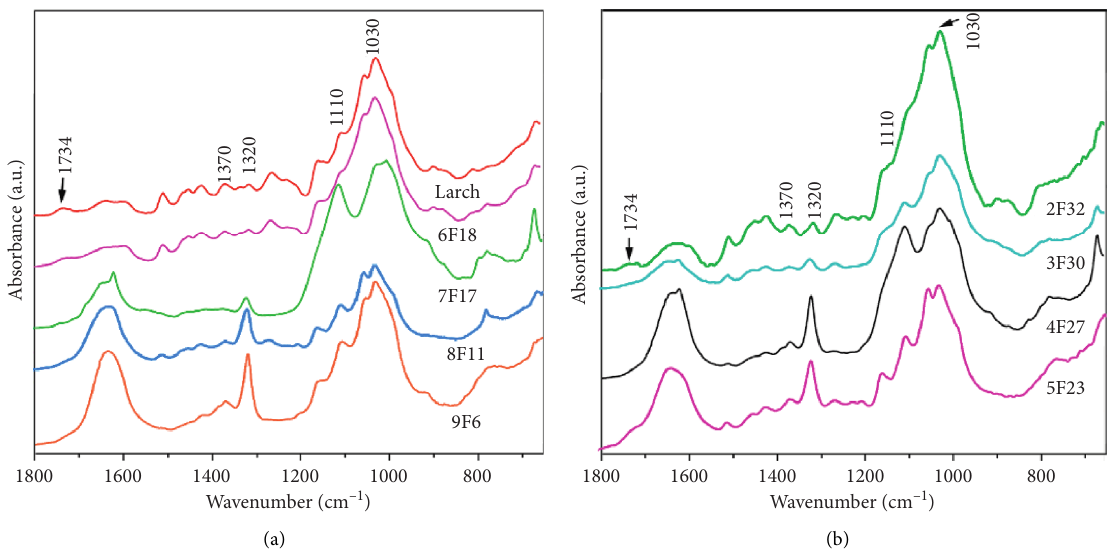
Figure 8: (a) FT-IR spectra of the sound wood sample (larch) and of aged wood samples 9F6, 8F11, 7F17, and 6F18. (b) FT-IR spectra of the samples 5F23, 4F27, 3F 30, and 2F 32. The peaks of polysaccharides are highlighted by indicating the wavenumber. Table 1: CrI and ∆ CrI of the sound and aged wood samples.